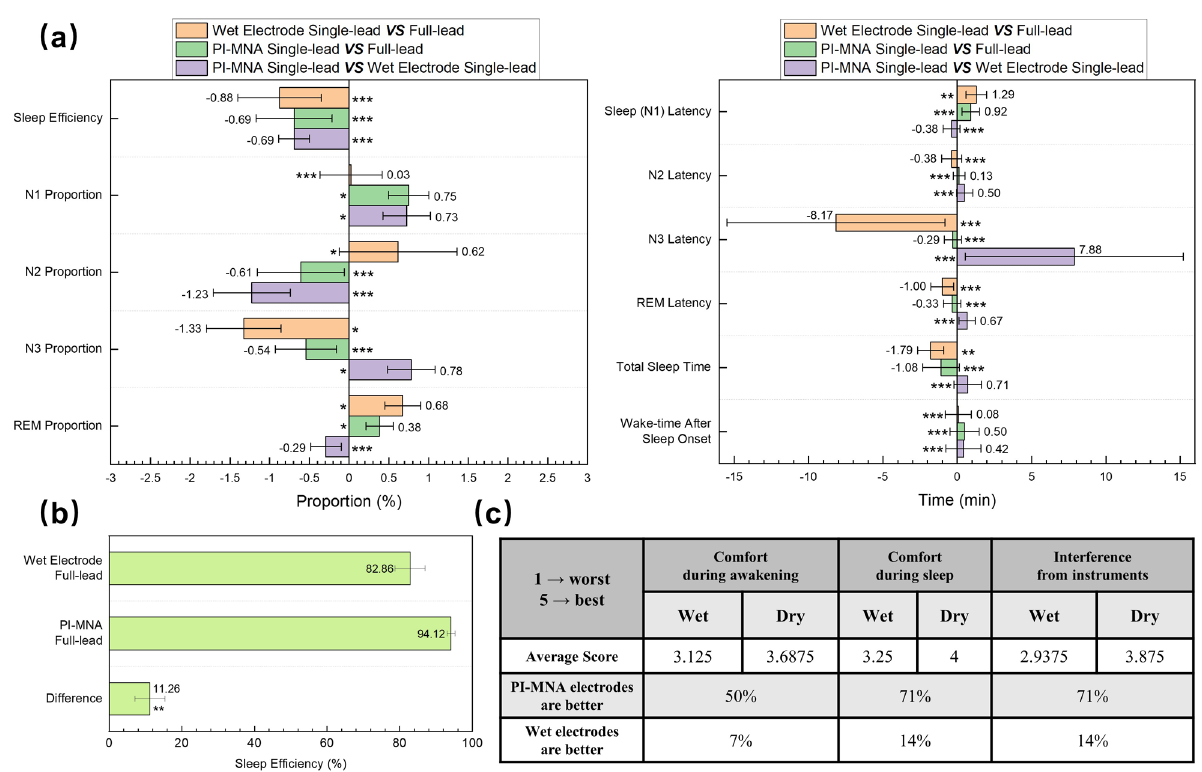
Fig. 10 a Sleep indicators compared using data from all leads, data from single-side wet electrode leads, and data from single-side PI-MNA electrode leads ( n = 12, mean ± standard error). “***”, “**”, and “*” indicate p > 0.1, p > 0.05, and p > 0.01 in the paired-samples t test. b Sleep efficiency analyzed from PSG data recorded by two electrode types during two nights of sleep monitoring for OSAHS subjects ( n = 16, mean ± standard error). “**” indicates p > 0.05 in the paired-samples t test. c Subjective evaluation of the sleep monitoring comfort with